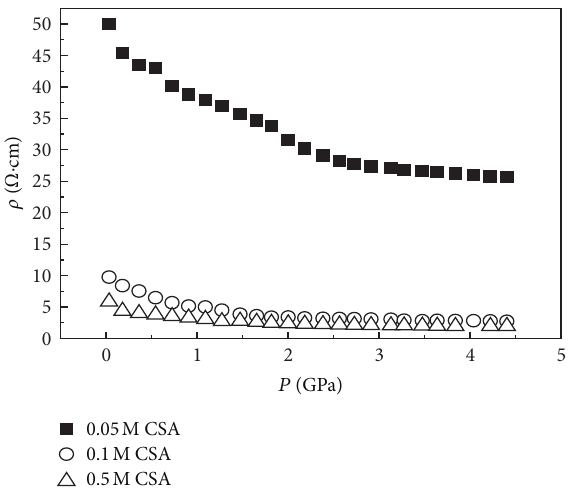
Figure 3: Effect of concentrations of CSA on resistivity of PAN under high pressure.